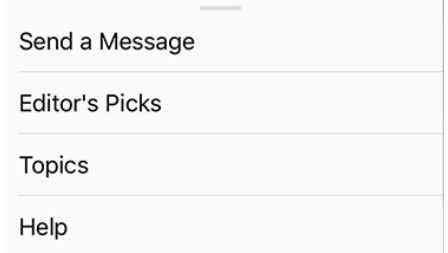
Fig. 11. CNN’s persistent menu on mobile app.